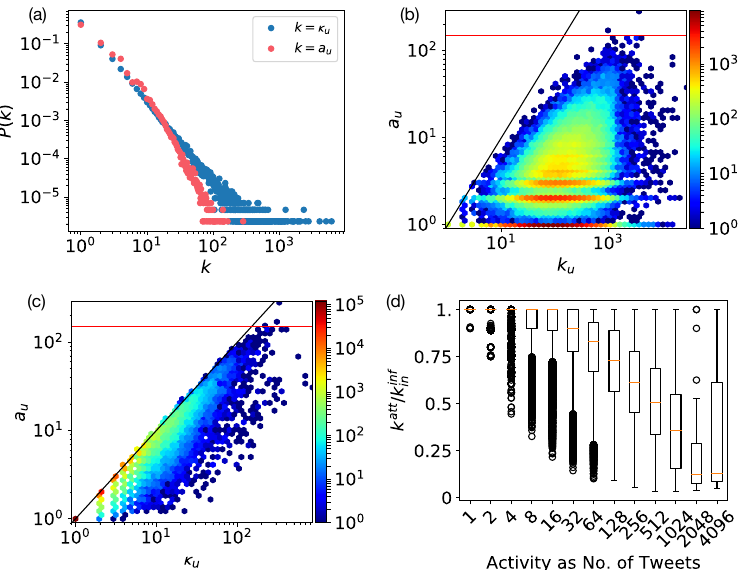
Figure 4. ( a ) The P(k) distributions of the k = a u attentional degree and the k = κ u out-degree of the retweet network. ( b ) Attentional degree vs. out-degree in follower network. ( c ) Attentional degree vs. out-degree κ u in the retweet network. ( d ) Ratio between attentional degree and retweet out-degree κ u / k u (y-axis) as a function of activity as the total n number of tweets and retweets (x-axis). All heat-map colors code absolute